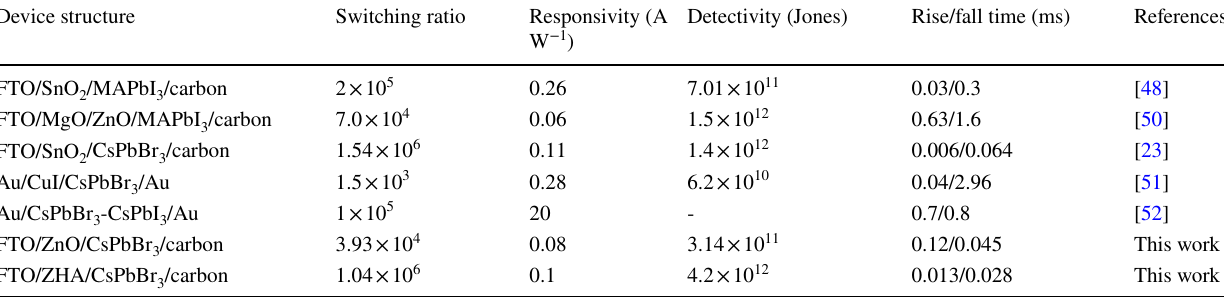
Table 1 Comparison of the perovskite PD performance Device structure